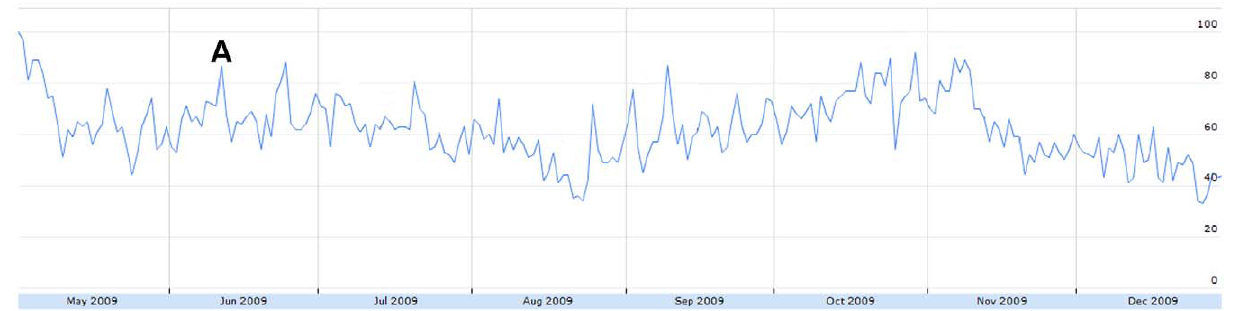
Figure 7. The relative proportion of tweets expressing frustration from May 1 to December 31, 2009. Figure was scaled to the highest peak on May 1 where 4.65% of all tweets expressed frustration. The peak was assigned a score of 100. A=June 11: WHO pandemic level 6 announcement.